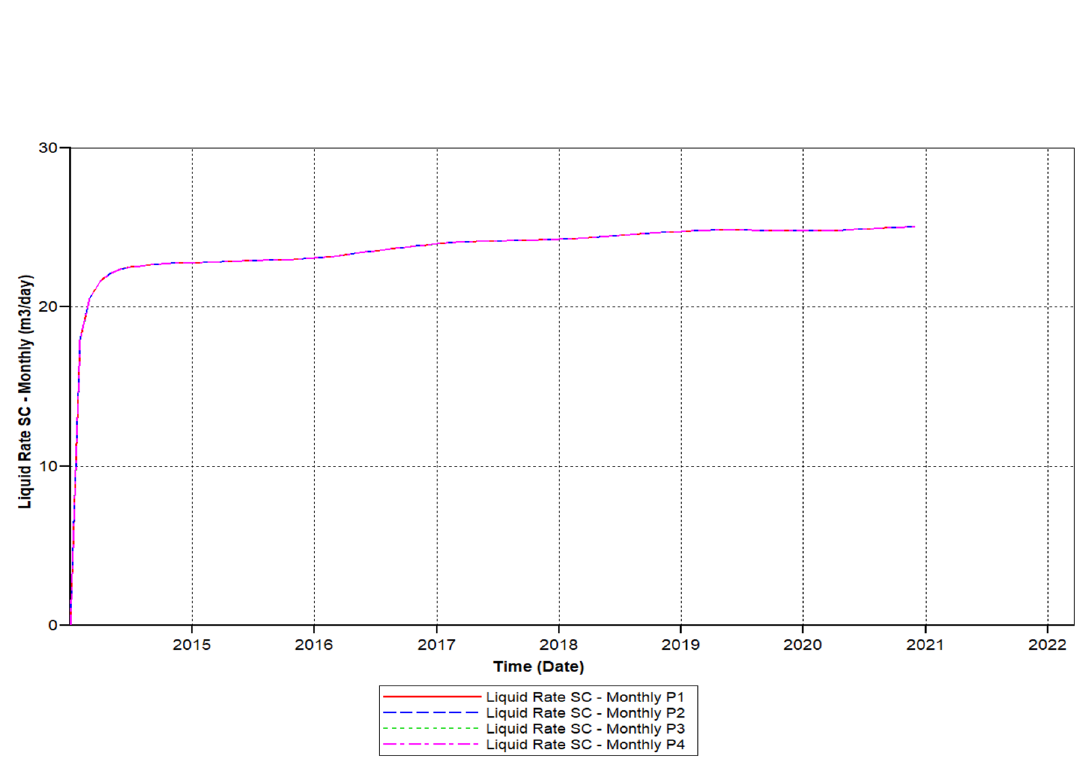
Figure 26. Indicates the liquid ratio afterward the cross-linked gel treatment graph CMG STARS 2017.10 URL: https:// www. cmgl.